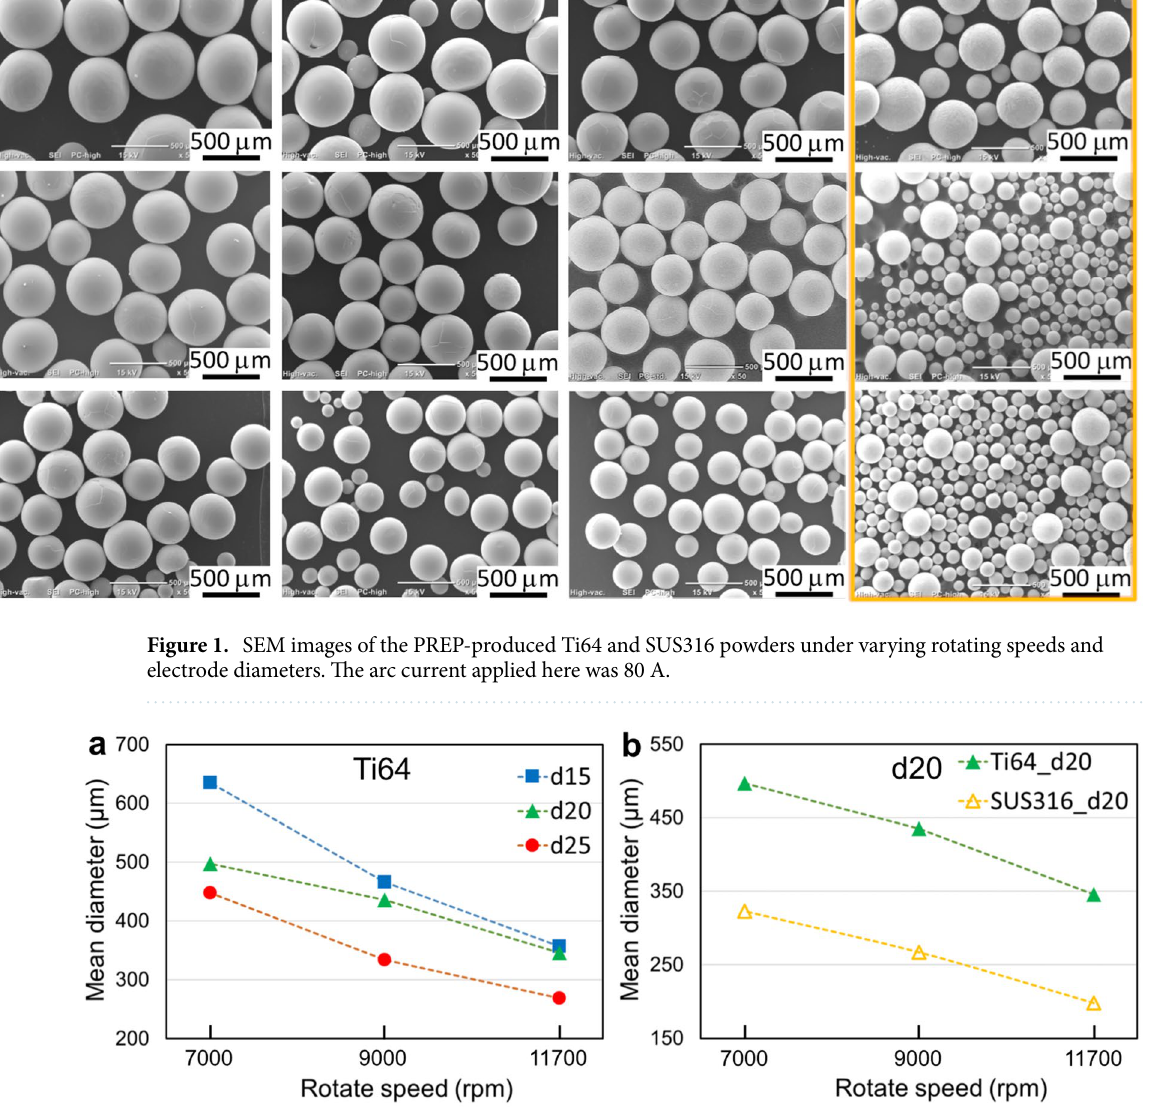
Figure 2. Corresponding mean diameters of the powders shown in Fig.